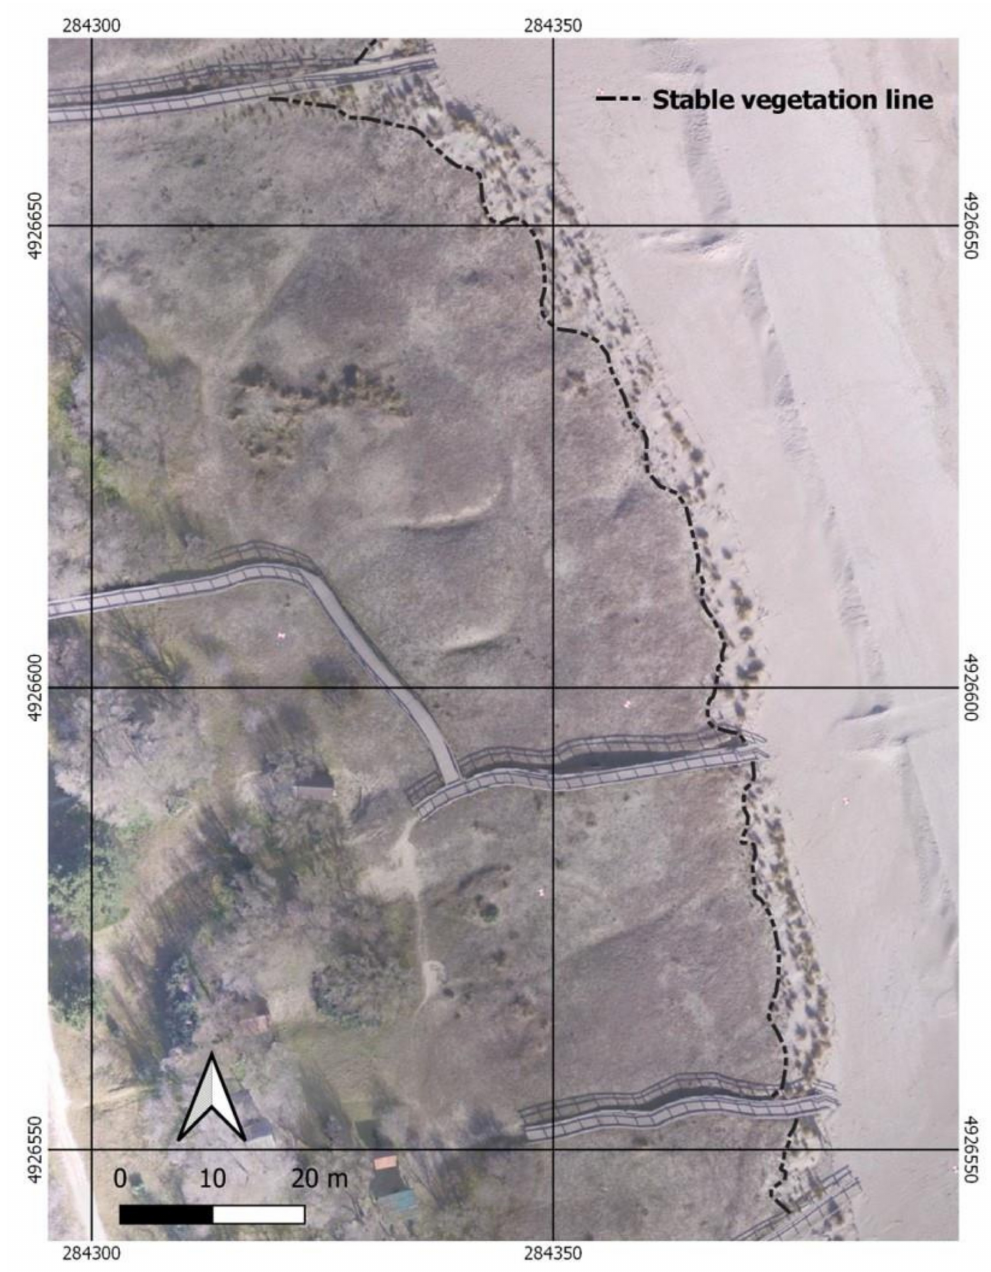
Figure 6. Example of high resolution orthomosaic (February 2020) used to identify the stable vegetation line